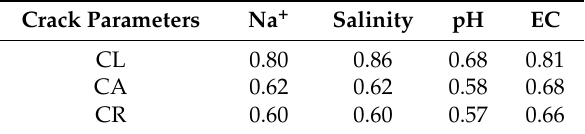
Table 5. Correlation coefficients between crack parameters and main soil properties.